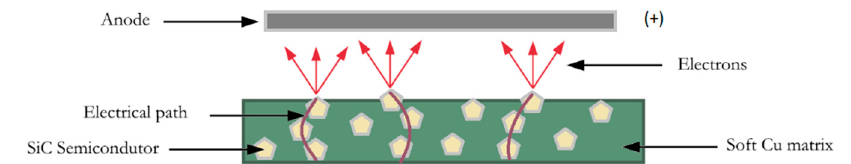
Figure 3. Sketch of composite cold-sprayed coating working as a cathode.